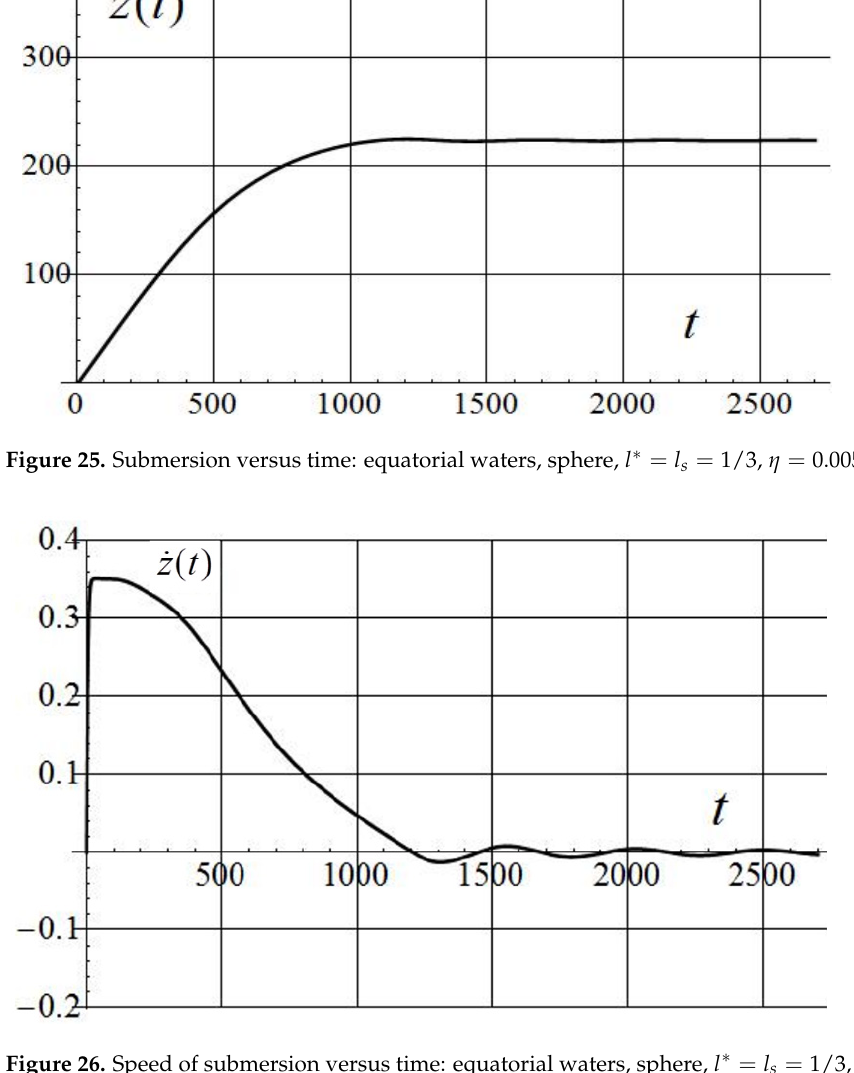
Figure 26. Speed of submersion versus time: equatorial waters, sphere, l ∗ = l s = 1/3, η =